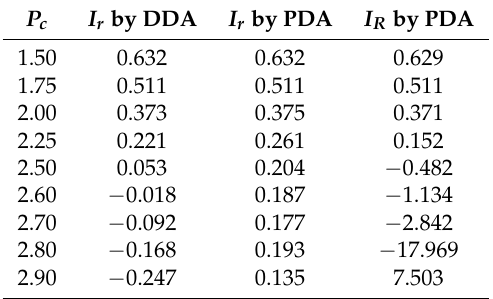
Table 1. Some values of the resilience indices I r and I R depending on the peak coefficient P c . In the second column Todini’s index I r is computed by using the DDA approach, instead in the third by using a PDA approach. The fourth column gives the index I R obtained through a PDA approach. P c